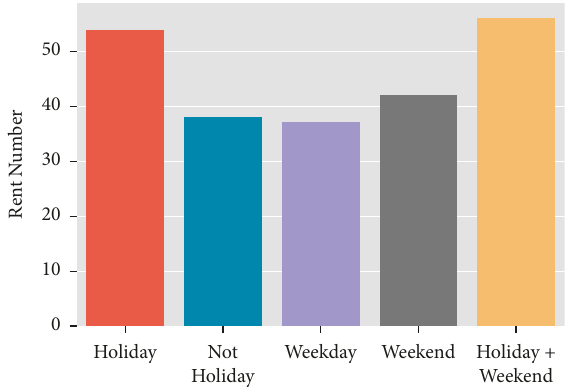
Figure 8: Effect of the holiday, weekend, and weekday on rental kickboard demand.